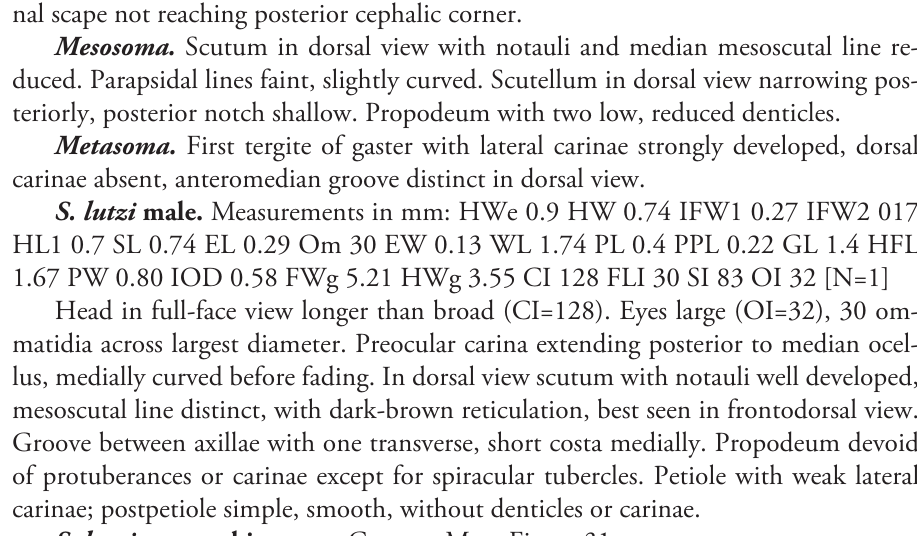
Figure 29. S. lutzi worker (USNMENT00445053), SEM images. a Head, full-face view b mandibles c mesosoma and metasoma, dorsolateral view d metasoma, dorsal view.